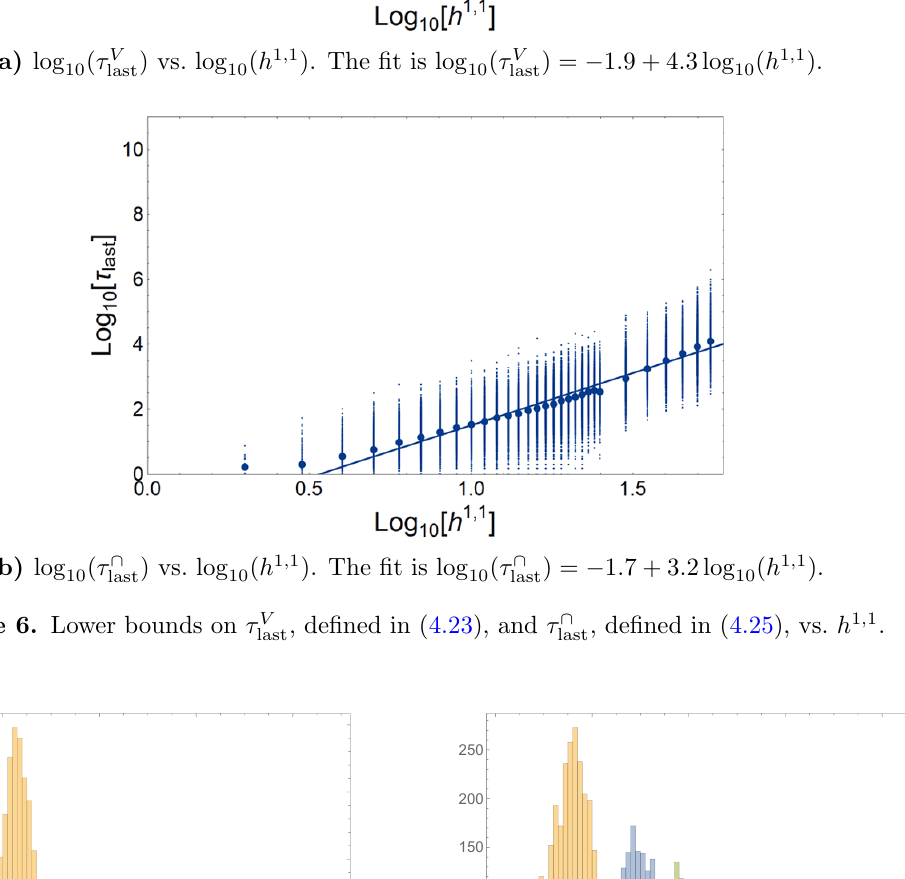
Figure 7. (cid:28) V (left) and (cid:28) \ (right) for h 1 ; 1 = 10 (leftmost peak), 30 (center peak), and 50 last last (rightmost